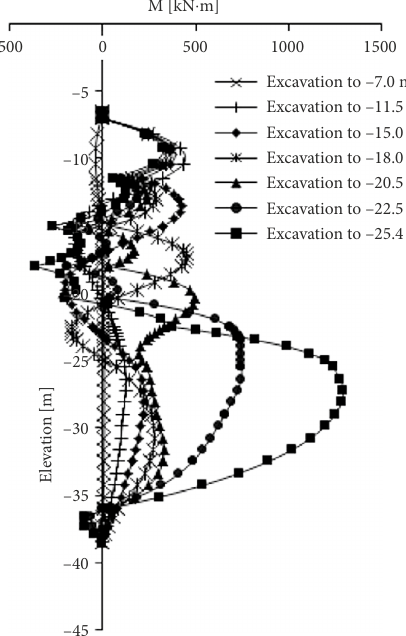
Figure 10. Influence of excavation depth on the bending moment of the diaphragm wall